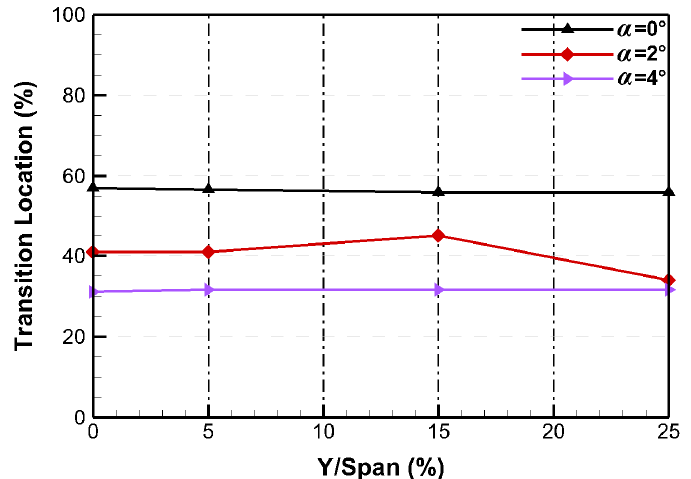
Figure 21. Comparison of the transition location of the central experiment wing with different α . Figure 22. The direction of the arrow represents the affected object, and the width of the arrow line represents the influence weight.